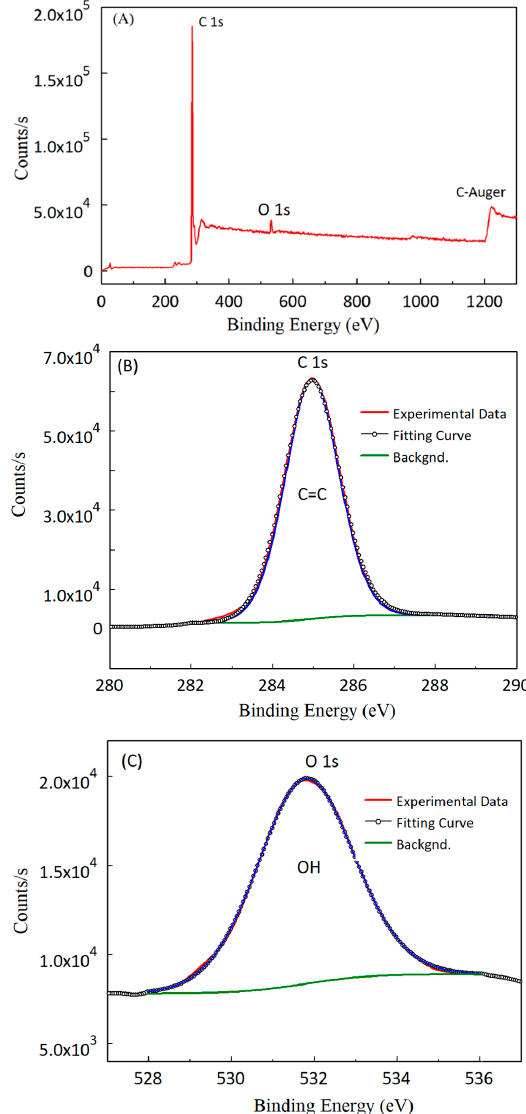
Figure 3. XPS analysis for the surface of CNTs-Ag electrode: ( A ) survey spectrum, ( B , C ) are the curve fittings of C 1s and O 1s spectra, respectively.